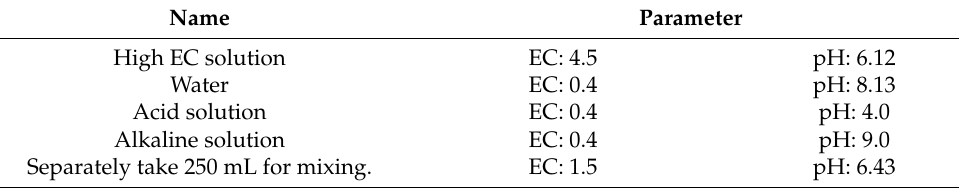
Table 5. Results of initial nutrient solution